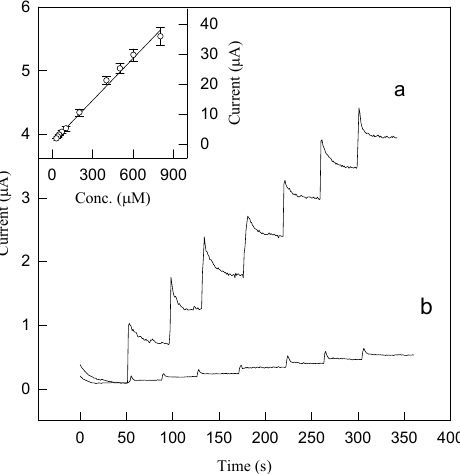
Figure 9. The current response to successive addition of tryptophan in 0.5 M KCl solution: (a) bare graphite electrode and (b) CuCoHCF-film modified electrode. The inset is the relationship of the current response of (b) with the tryptophan concentration. Applied potential: 0.65